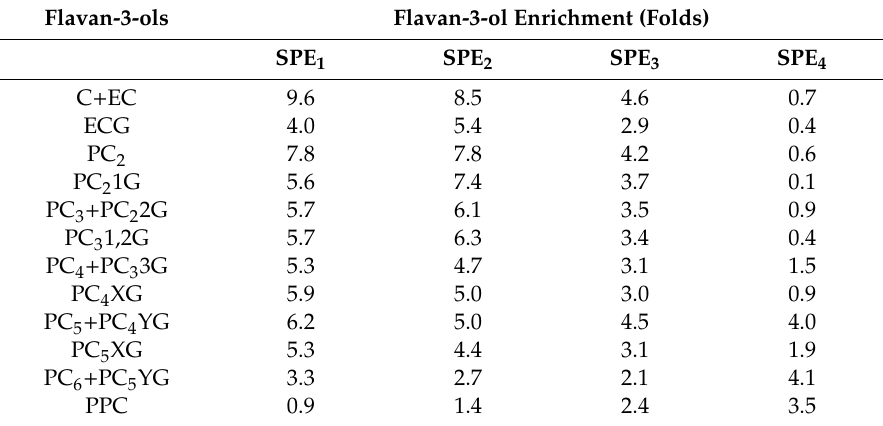
Table 2. Flavan-3-ol enrichment (by groups) in purified OPC fractions after UF and after each of the four consecutive SPE